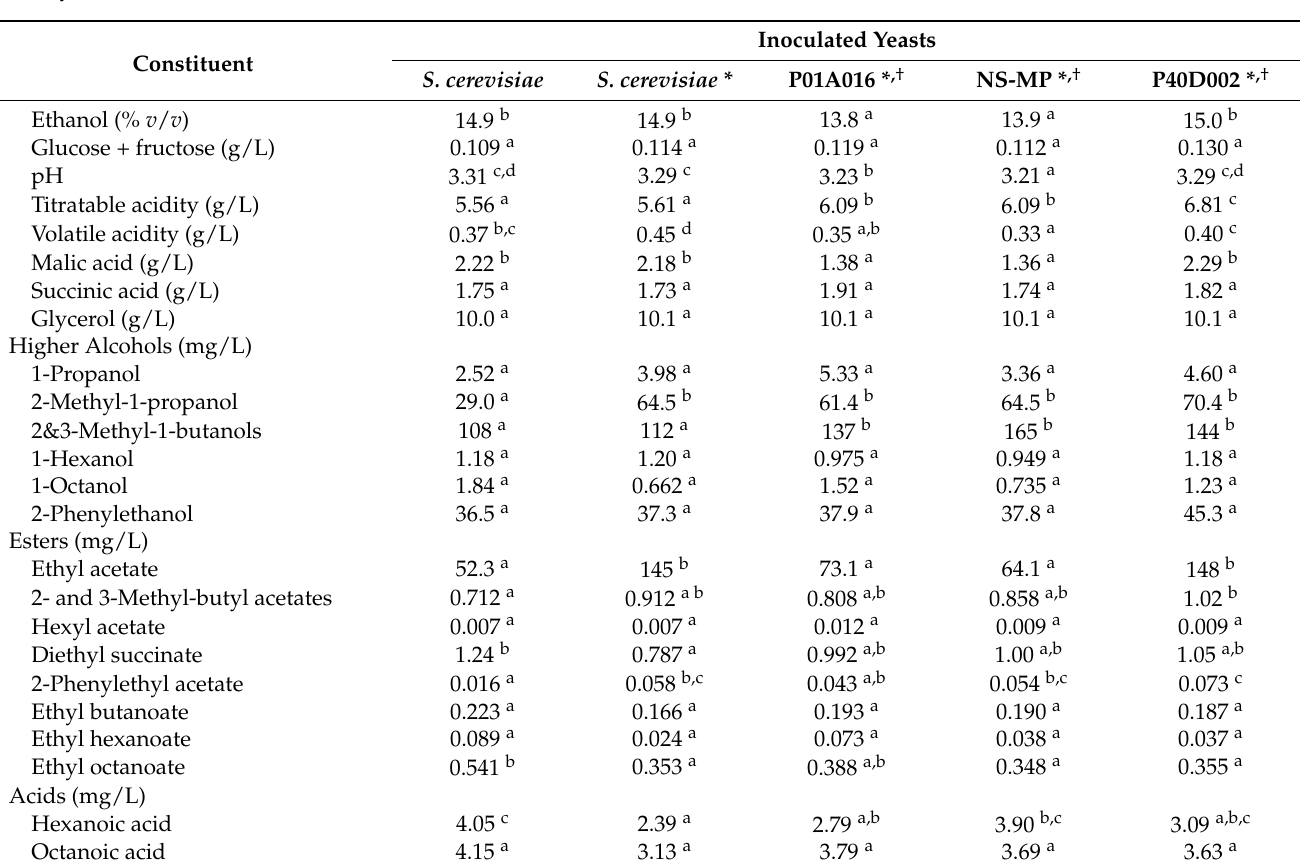
Table 1. Concentration of volatile compounds in Merlot wines inoculated with or without non- Saccharomyces yeasts followed by S. cerevisiae .